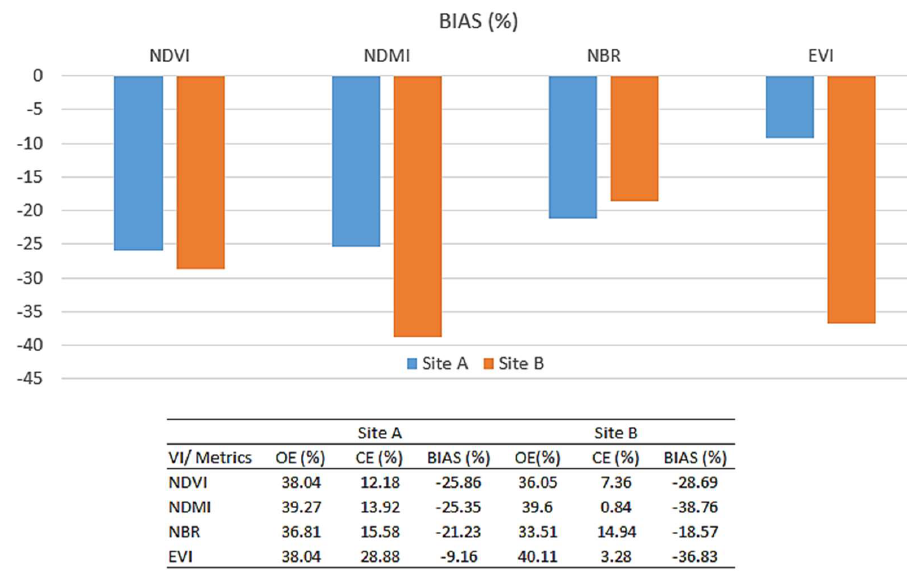
Figure 9. The percentage of BIAS, omission error and commission error in sites A and B.